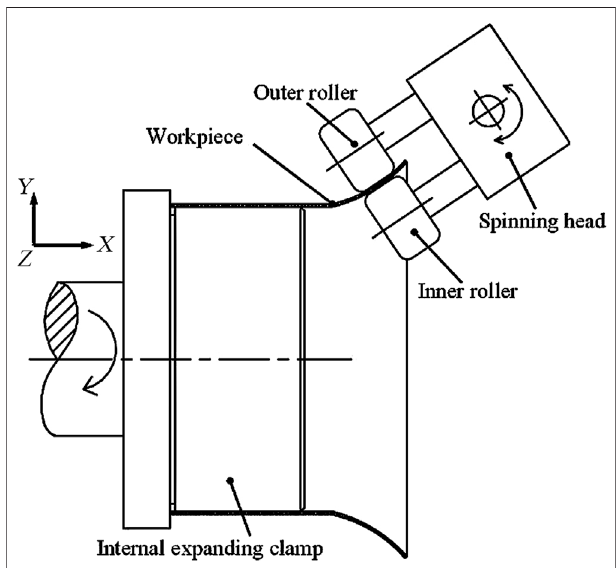
FIGURE 1 | Schematic illustration of the DRCS